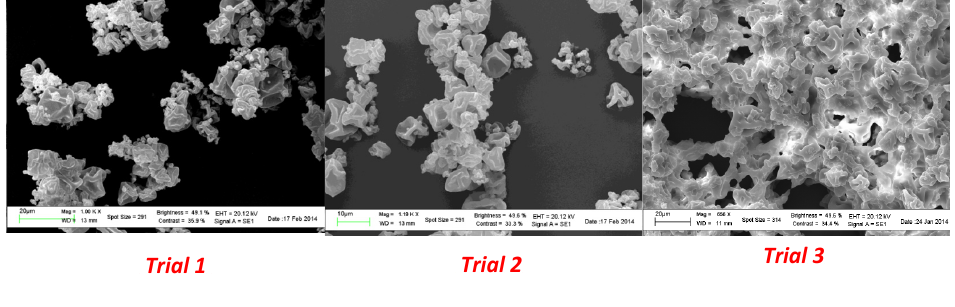
Molecules 2023 , 28 , x FOR PEER REVIEW 8 of 15